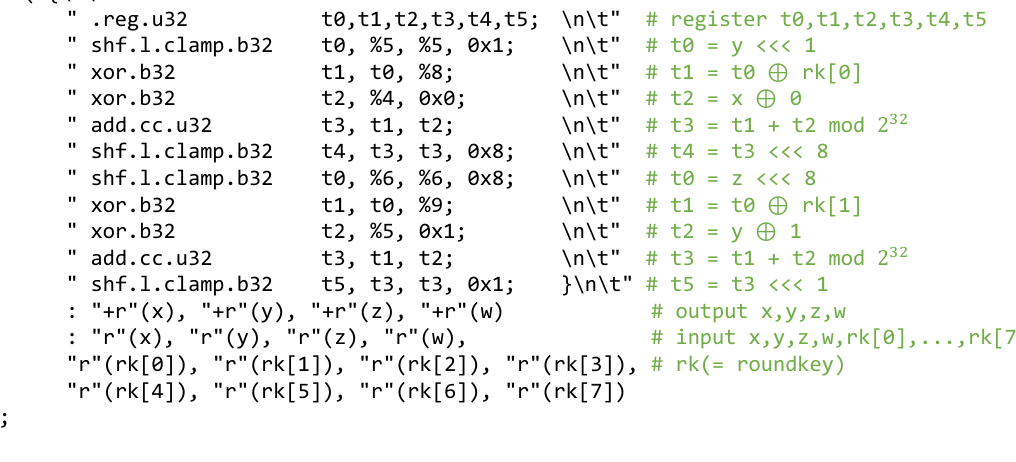
Figure 9. Inline PTX code of CHAM round